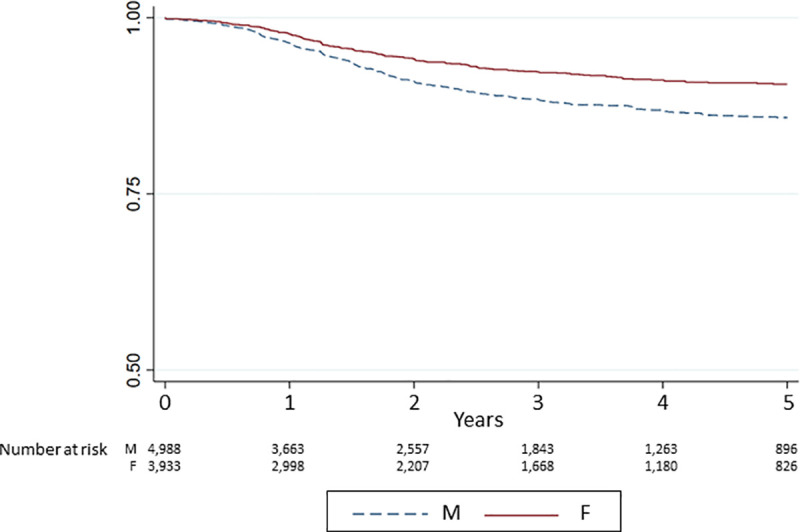
Waitlist access.Cumulative incidence curve of being waitlisted after entering dialysis treatment.